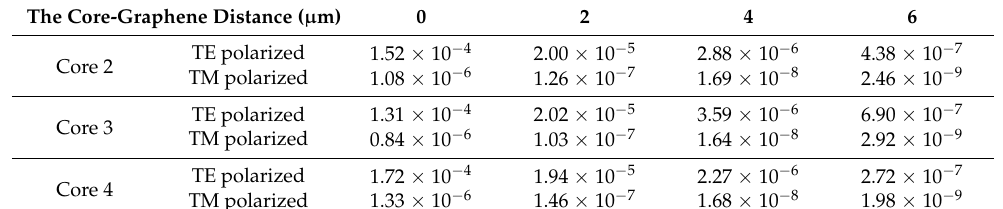
Table 2. The imaginary part of the effective refractive index for three cores.